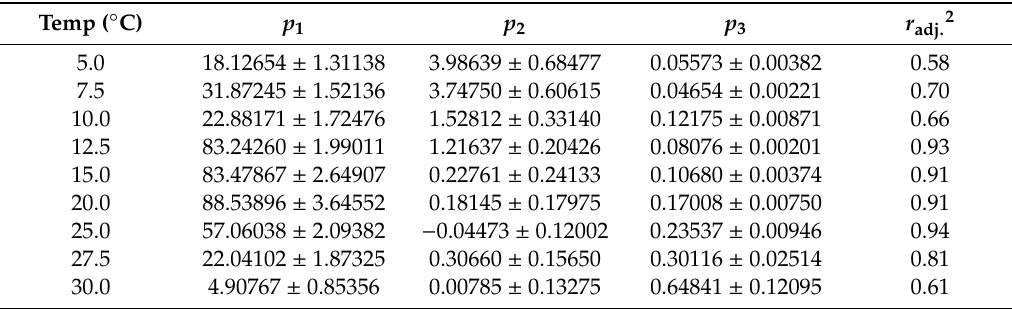
Table 6. Parameters estimated from the daily fecundity model (Equation (7)) of A. solani adults at constant temperatures.